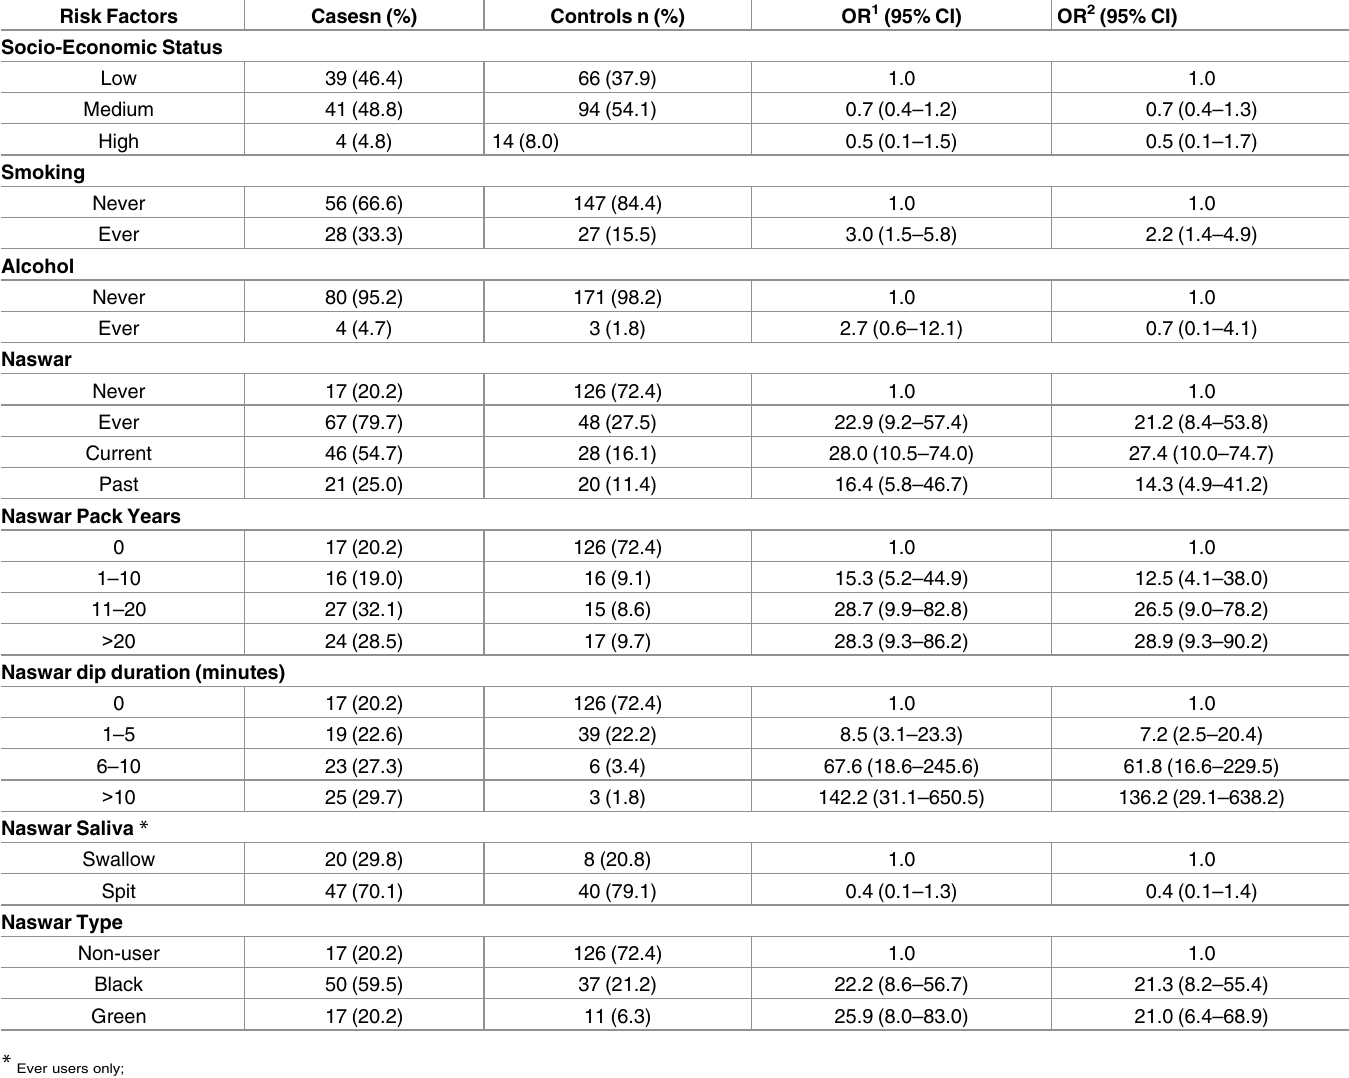
Table 3. Risk of oral cancer associated with the lifestyle risk factors among both sexes (84 cases, 174 controls) in Khyber Pakhtunkhwa, Pakistan, derived from conditional logistic regression (conditioned on age and